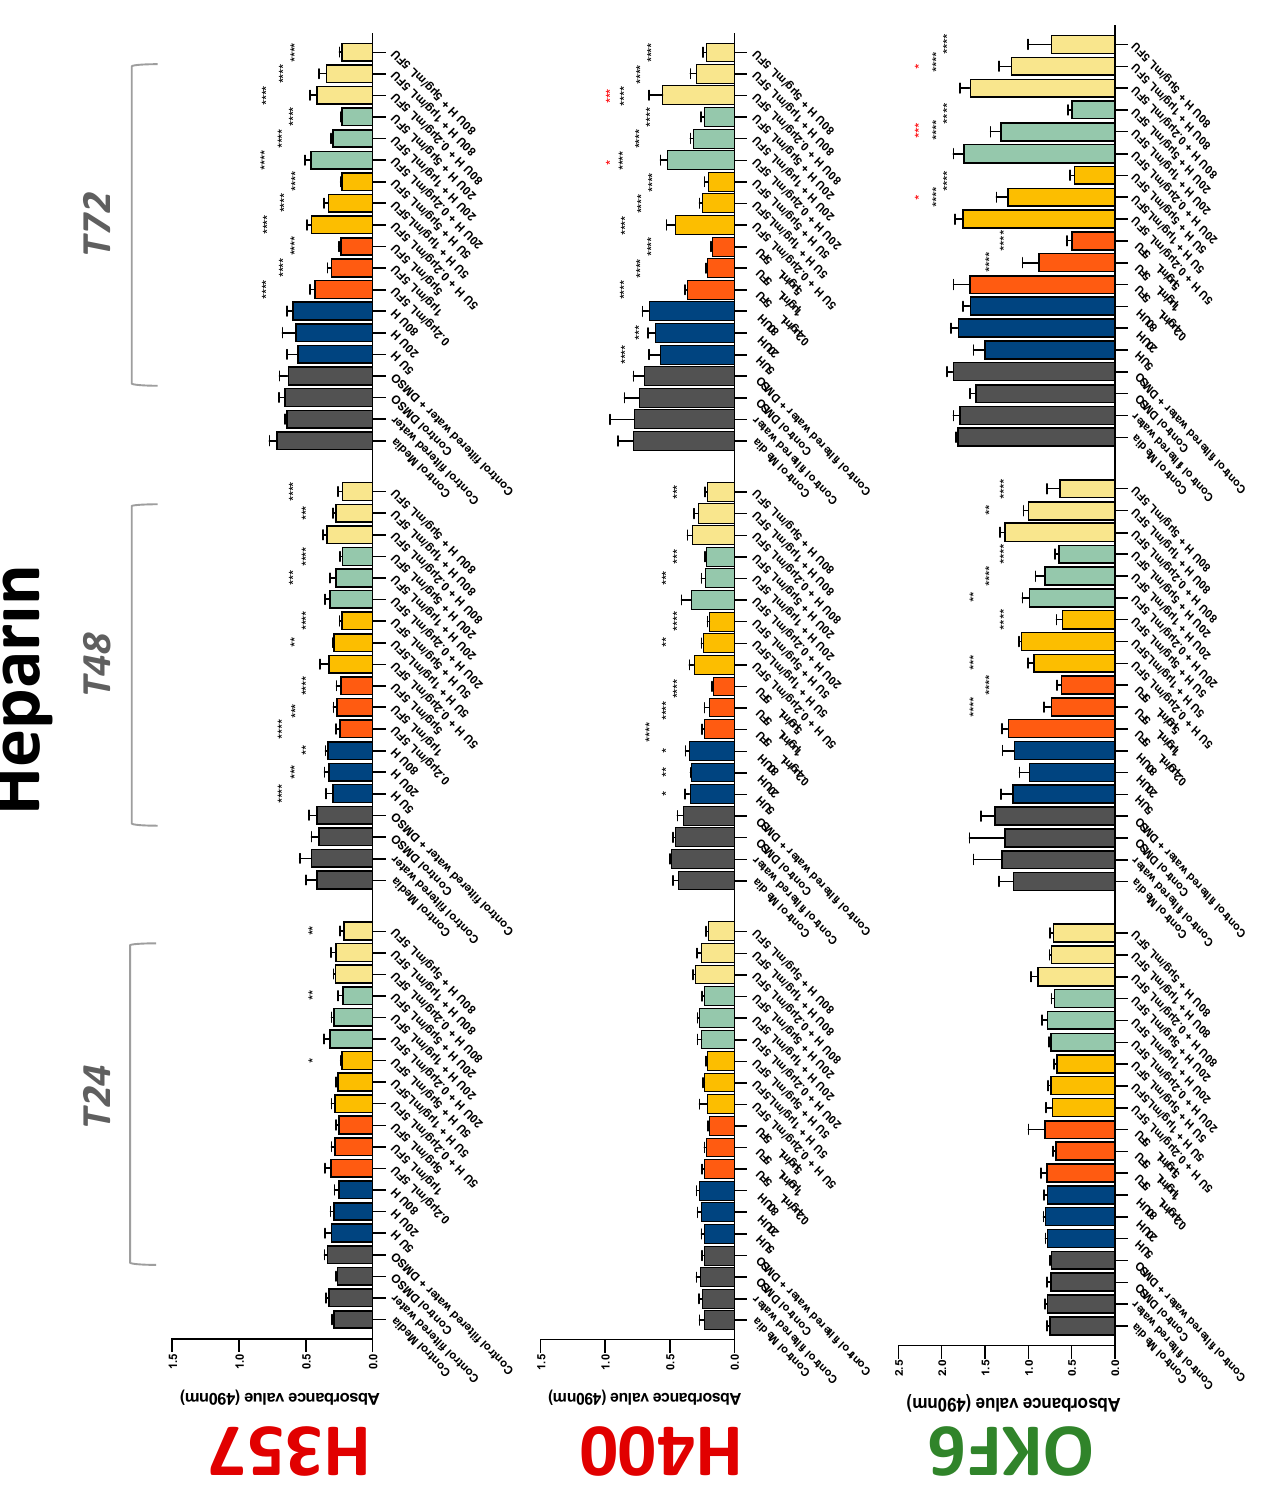
Figure 2. MTS assay . The effect of (5/20/80 U) heparin and (0.2/1/5/10 μ g/mL) 5-FU on H357, H400, and OKF6 cell proliferation. Data are represented as mean ± SD. Statistical significance is given as follows: * p < 0.05, ** p < 0.01, *** p < 0.005, **** p < 0.001; * (black) compared to control group; * (red) compared to respective 5-FU groups.